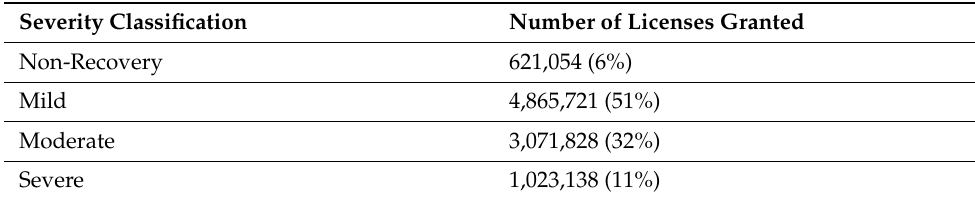
Table 1. Severity Classifications of Licenses Granted in EU 2017 [27] (p.